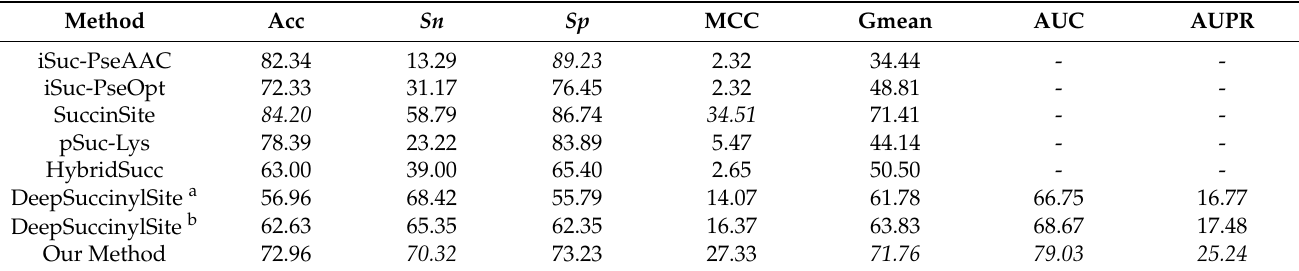
Table 3. Comparison of MDCAN-Lys with existing predictors using the independent test set (the data are percentages). DeepSuccinylSite a and DeepSuccinylSite b represent DeepSuccinylSite with one-hot encoding and embedding encoding. The highest value in each category is shown in